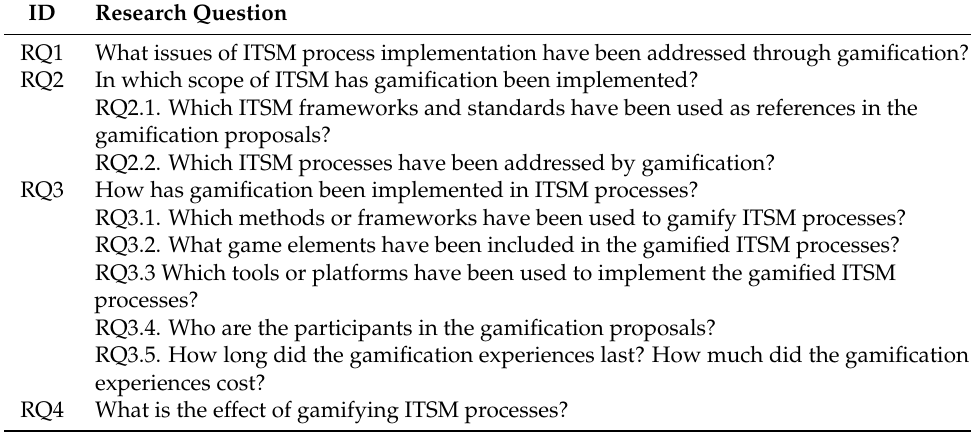
Table 2. Research questions